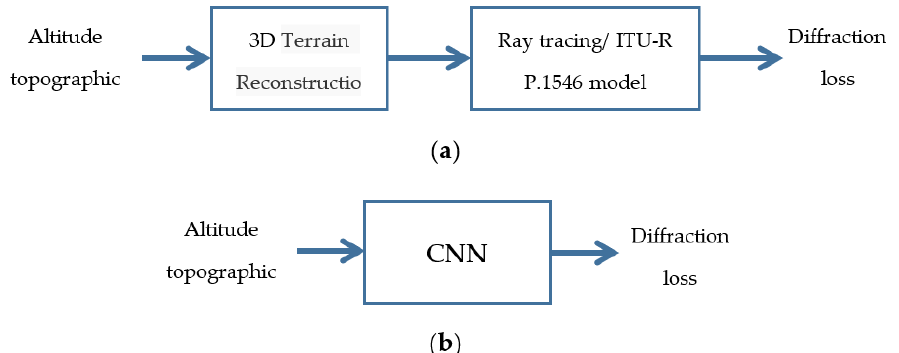
Figure 1. Loss prediction method based on altitude topographic map. ( a ) Model-based method; ( b ) CNN-based method.